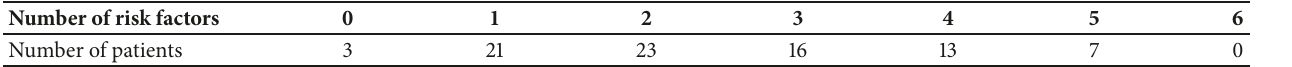
Table 6: Proportion of stroke patients with multiple risk